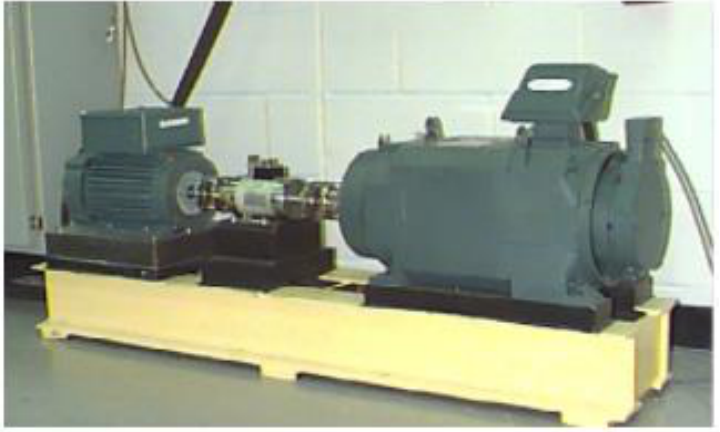
Figure 7. Bearing simulator of CWRU.